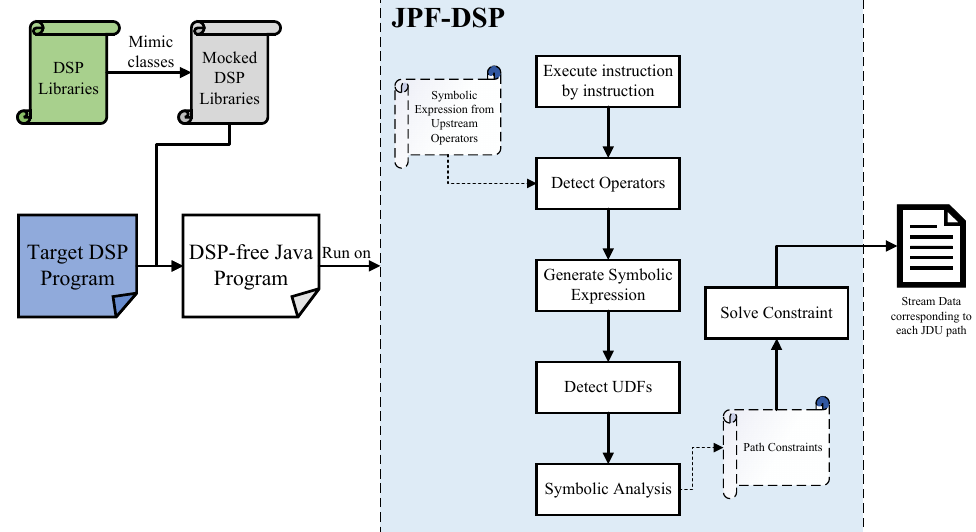
Figure 4. Approach overview of symbolic